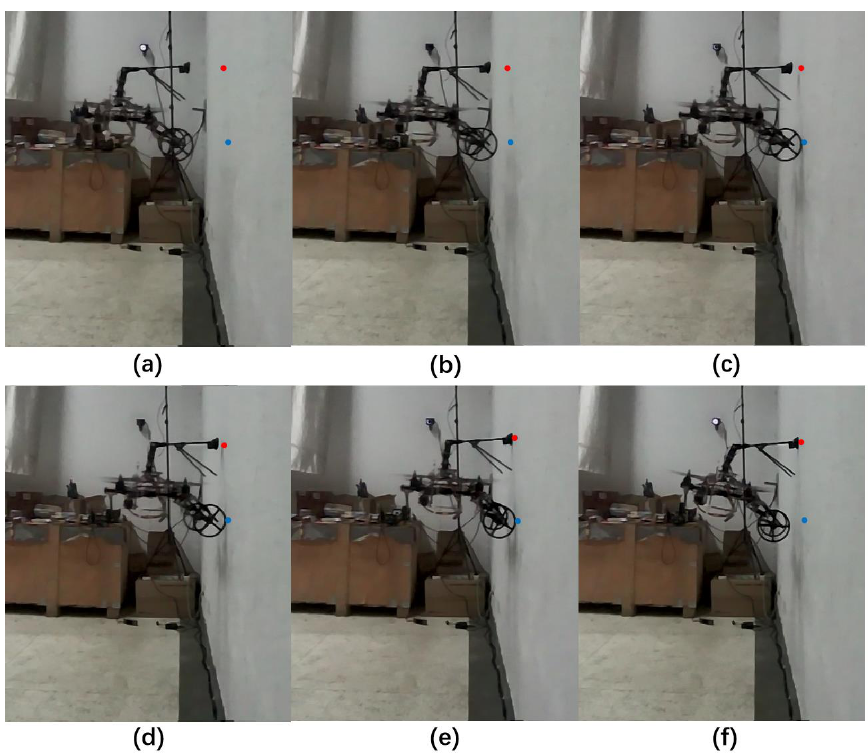
Figure 19. Robot flight adsorption step diagram (the red point is the contact point between the suction cup and the wall, and the blue point is the contact point between the right wheel and the wall).